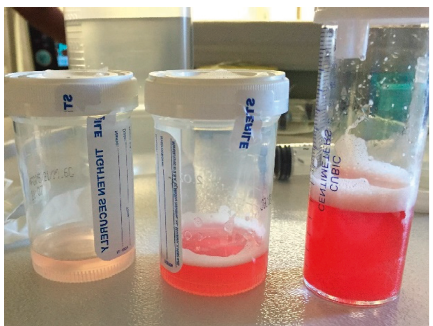
Figure 4: Progressive increase in intensity of blood in sequential aliquots during BAL strongly suggests active alveolar hemorrhage.